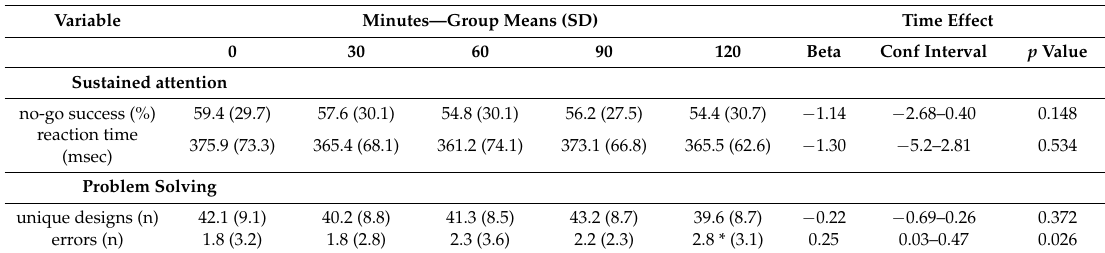
Table 2. Cognitive function [mean (standard deviation)] over 2 h of prolonged sitting with coefficient (Beta) for effect of time.